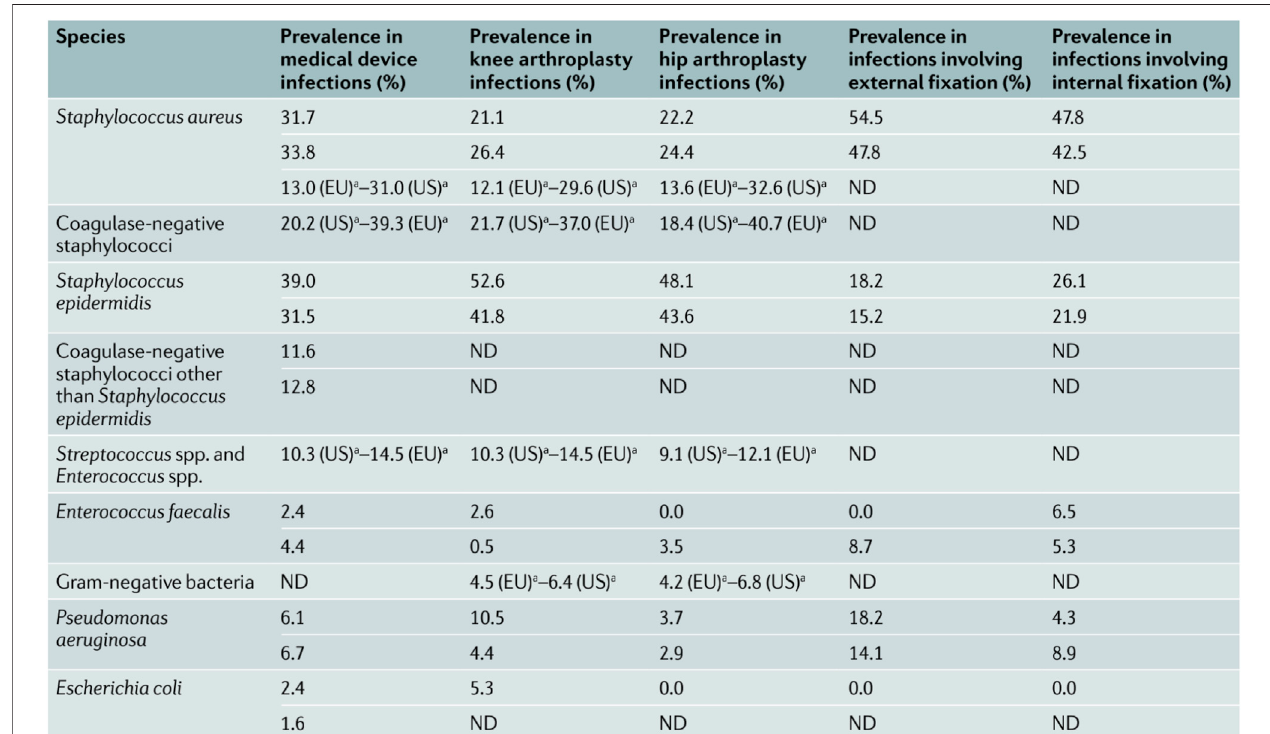
FIGURE 1 | Major bacteria causing implant-associated infections. Reproduced from Arciola et al (2018). Copyright (2018), with permission from Springer Nature.